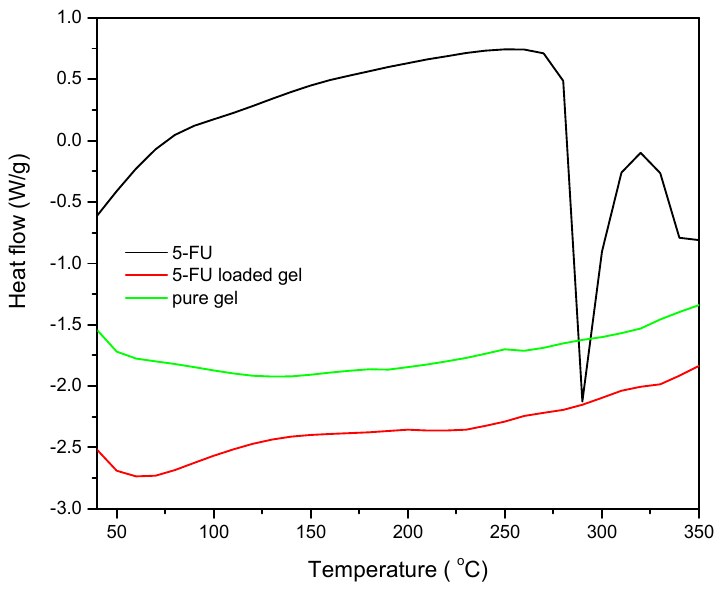
Figure 3. DSC curves of PPK hydrogel for P2 formulation: pure PPK hydrogel, 5-FU-PPK hydrogel, and 5-FU.